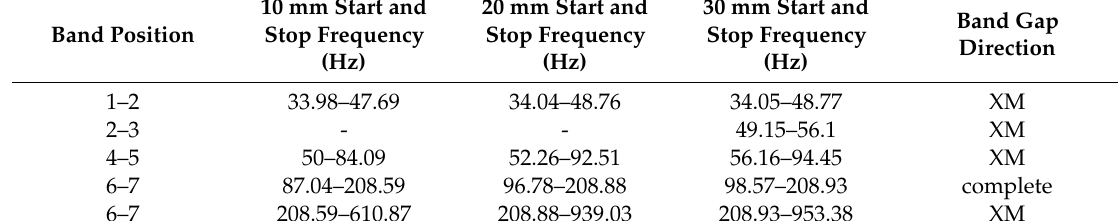
Table 2. Band gaps for 10, 20, and 30 mm-thick phononic crystals plate.